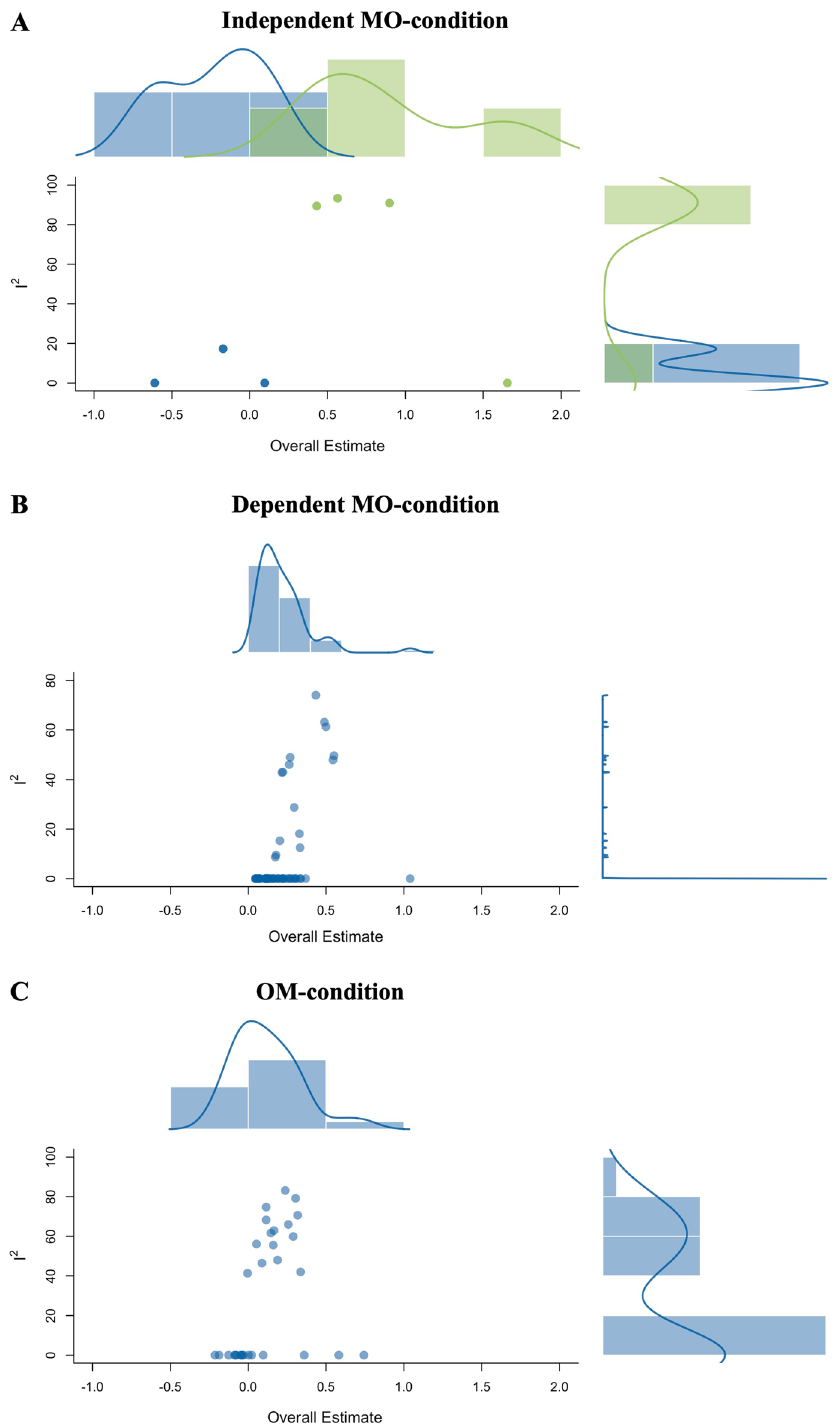
Figure 7. GOSH-plots of all possible combinations for each condition. The independent MO-condition includes studies with pretest–posttest designs of independent groups examining exposure to KV448 versus silence 11,27,28 . The dependent MO-condition includes studies with one-group pretest–posttest designs examining exposure to KV448 versus silence 7,12,25,26 . The OM-condition includes studies with one-group pretest–posttest designs examining exposure to other music than KV448 versus silence 12,25,26,29 . Panel ( A ) shows all 7 possible combinations of k = 3 studies included in the independent MO-condition, whereas subset estimations including the study which reported the largest effect size (Bergomi et al. 2014; third-party-reported pain in premature infants) is highlighted in green. Panel ( B ) shows all 63 possible combinations of k = 6 studies included in the dependent MO-condition. Panel ( C ) shows all 31 possible combinations of k = 5 studies included in the OM-condition. In all conditions, results of combinatorial meta-analyses did not reveal evidence for a salient beneficial effect of either exposure to KV448 or any other kind of music on epilepsy or other medically relevant